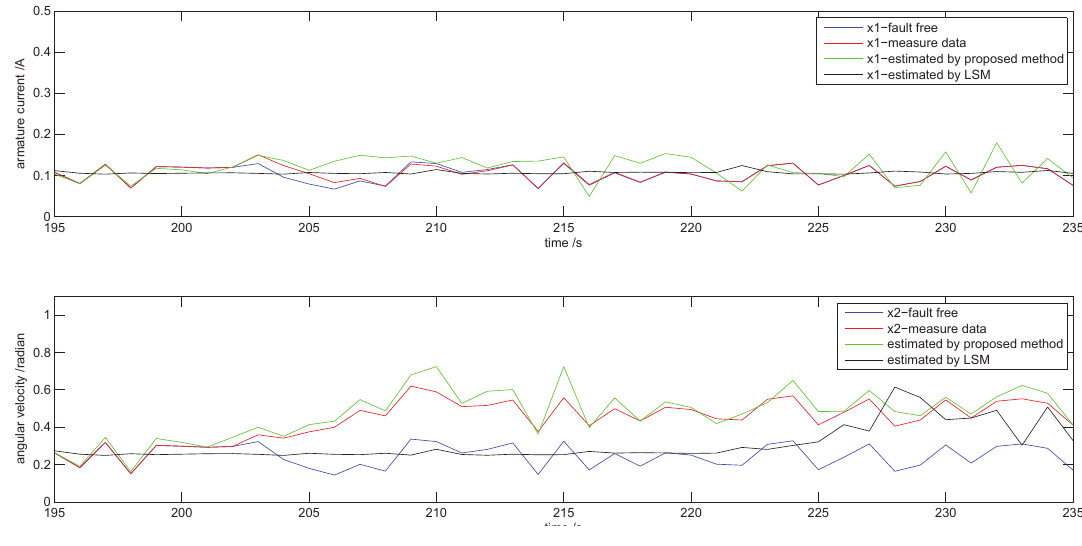
Figure 5. The evolution of states (from